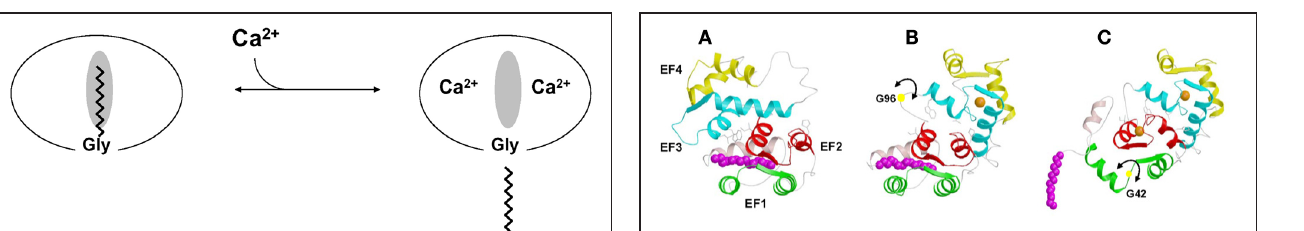
FIGURE 2 | Schematic diagram of calcium-myristoyl switch in recoverin. The binding of two Ca 2 + ions promotes the extrusion of the myristoyl group and exposure of other hydrophobic residues (marked by the shaded oval). This figure was adapted from and originally published by Zozulya and Stryer (1992).